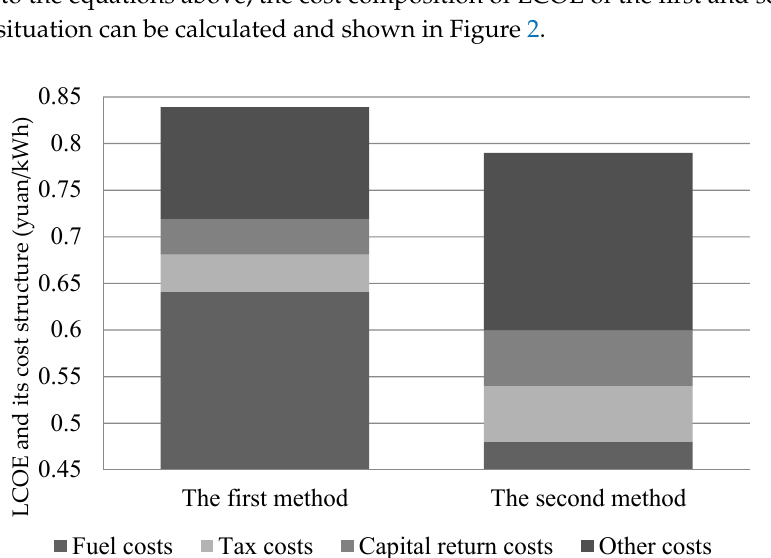
Figure 3. National profitability map.